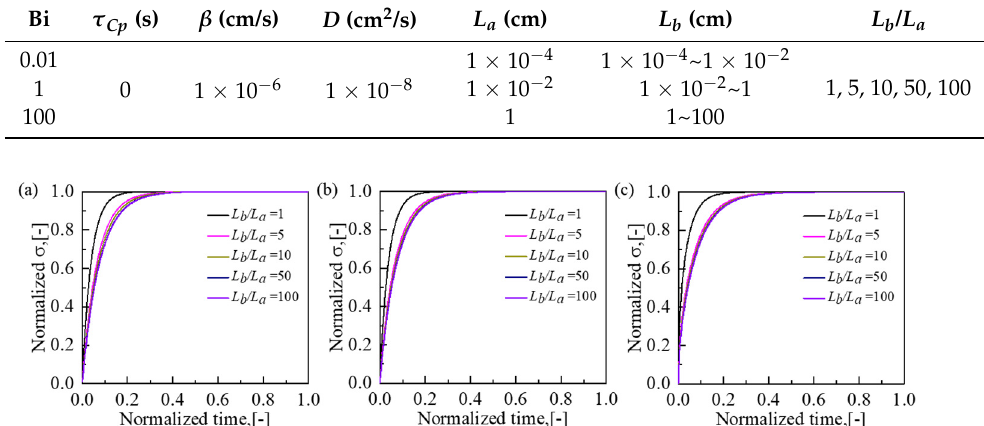
Table 1. Parameters of conductivity relaxation with different Bi.